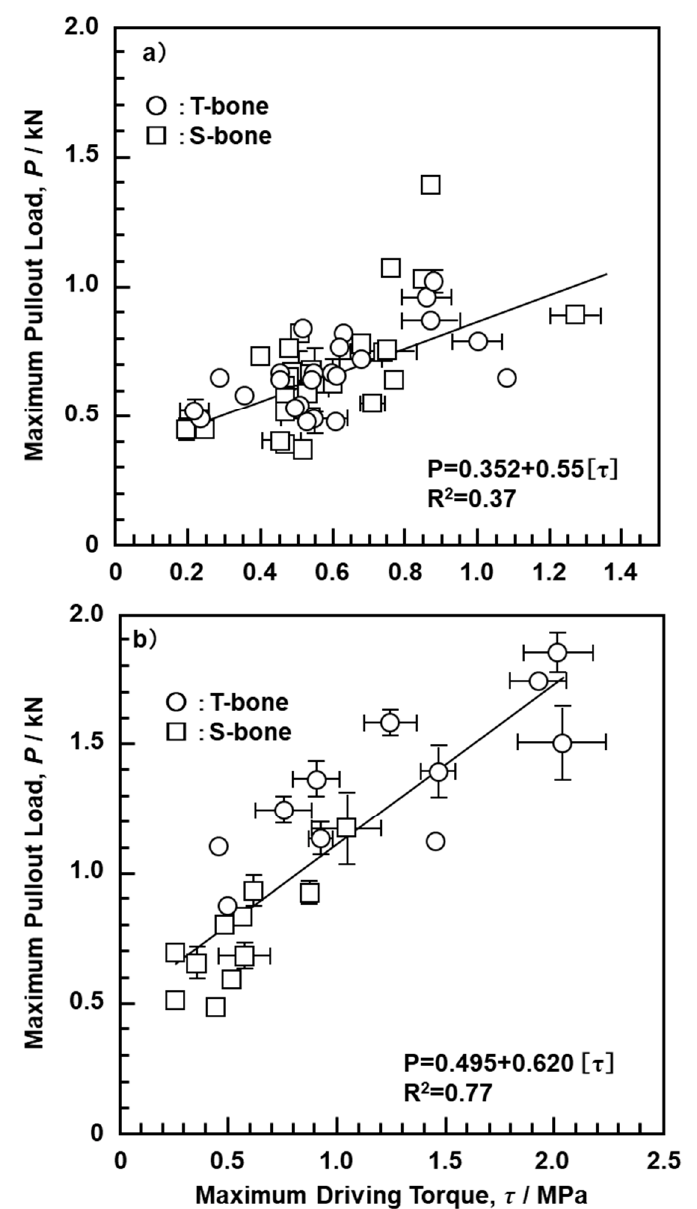
Figure 13. Relationship between maximum pullout load and maximum driving torque with ( a ) SRPF grade 15 and ( b ) CRPF grade 20.